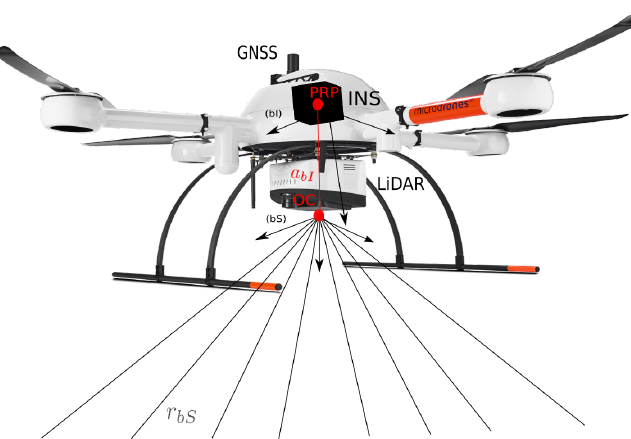
Figure 1. A typical LiDAR system mounted on a drone. Lever arms is denoted by a bI . The LiDAR local frame is denoted by bS = ( X bS , Y bS , Z bS ) , and the inertial measurement unit (IMU) frame by bI = ( X bI , Y bI , Z bI ) . Boresight angles define the transformation from frame ( bS ) to frame ( bI ) , denoted by C bI bS